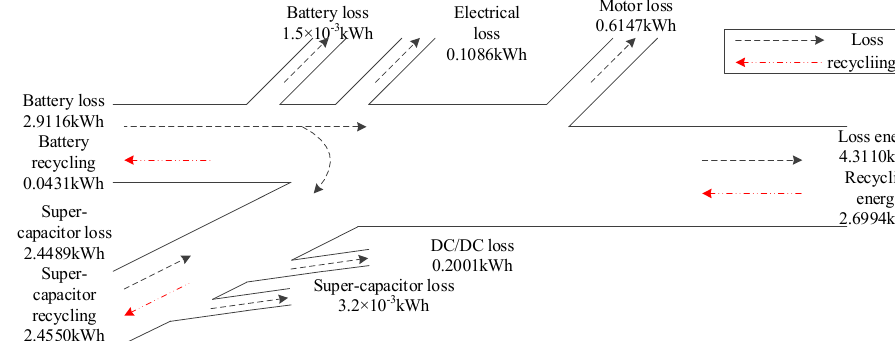
Figure 17. Energy flow chart of lithium battery as a single energy source.